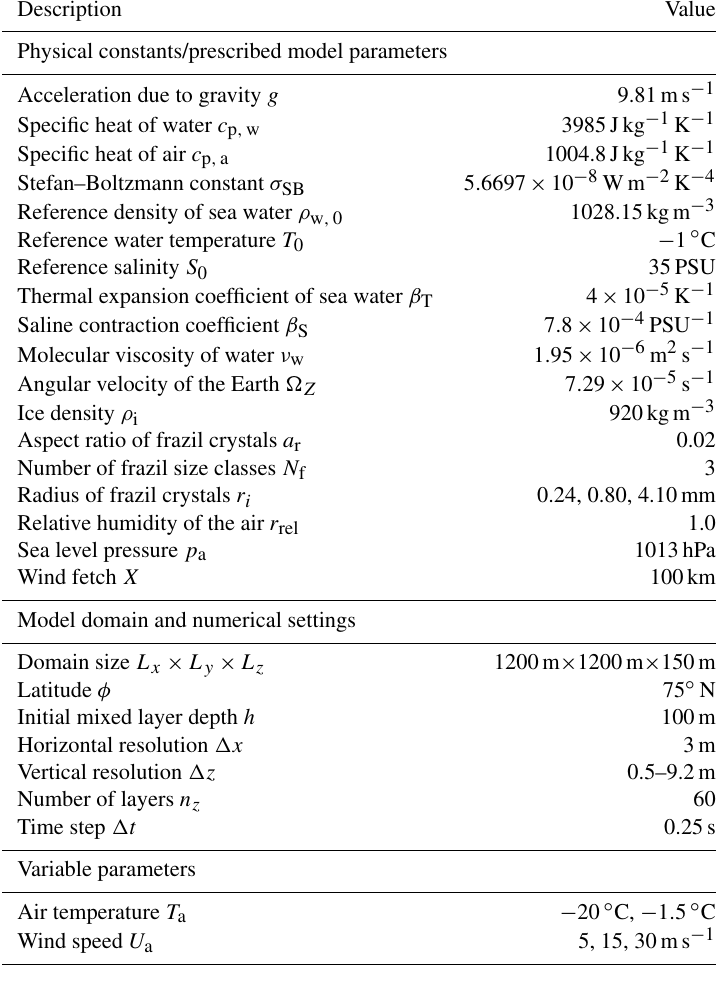
Table 1. Setup of the CROCO model used in this